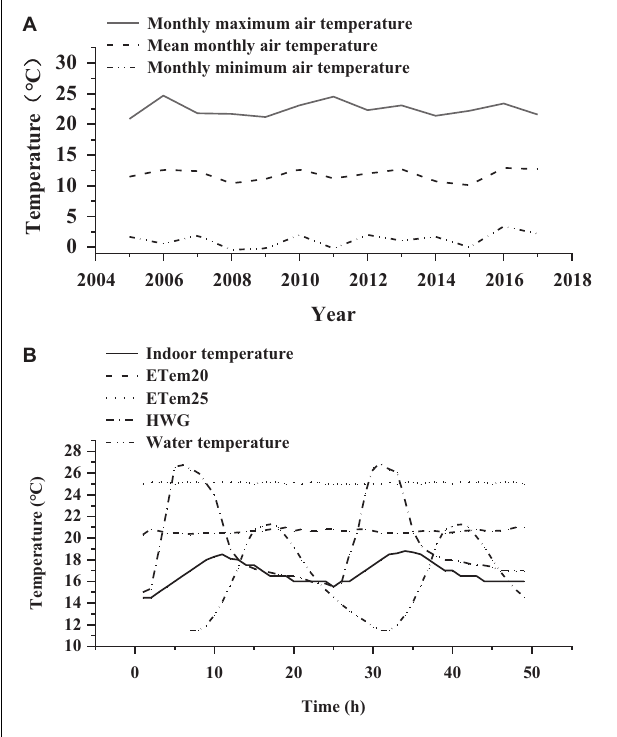
FIGURE 1 | (A) Monthly maximum air temperature, mean monthly air temperature, and monthly minimum air temperature in August in Maqu County from 2005 to 2017. (B) Changes in temperature in ETem20, ETem25, and HWG, and changes in indoor temperature and water temperature of Nanorana pleskei for 2 consecutive days. ETem20, ETem25, HWG, and water temperature represent the group that elevated temperature to 20 ◦ C, the group that elevated temperature to 25 ◦ C, water temperature at sampling site heat, and wave group,